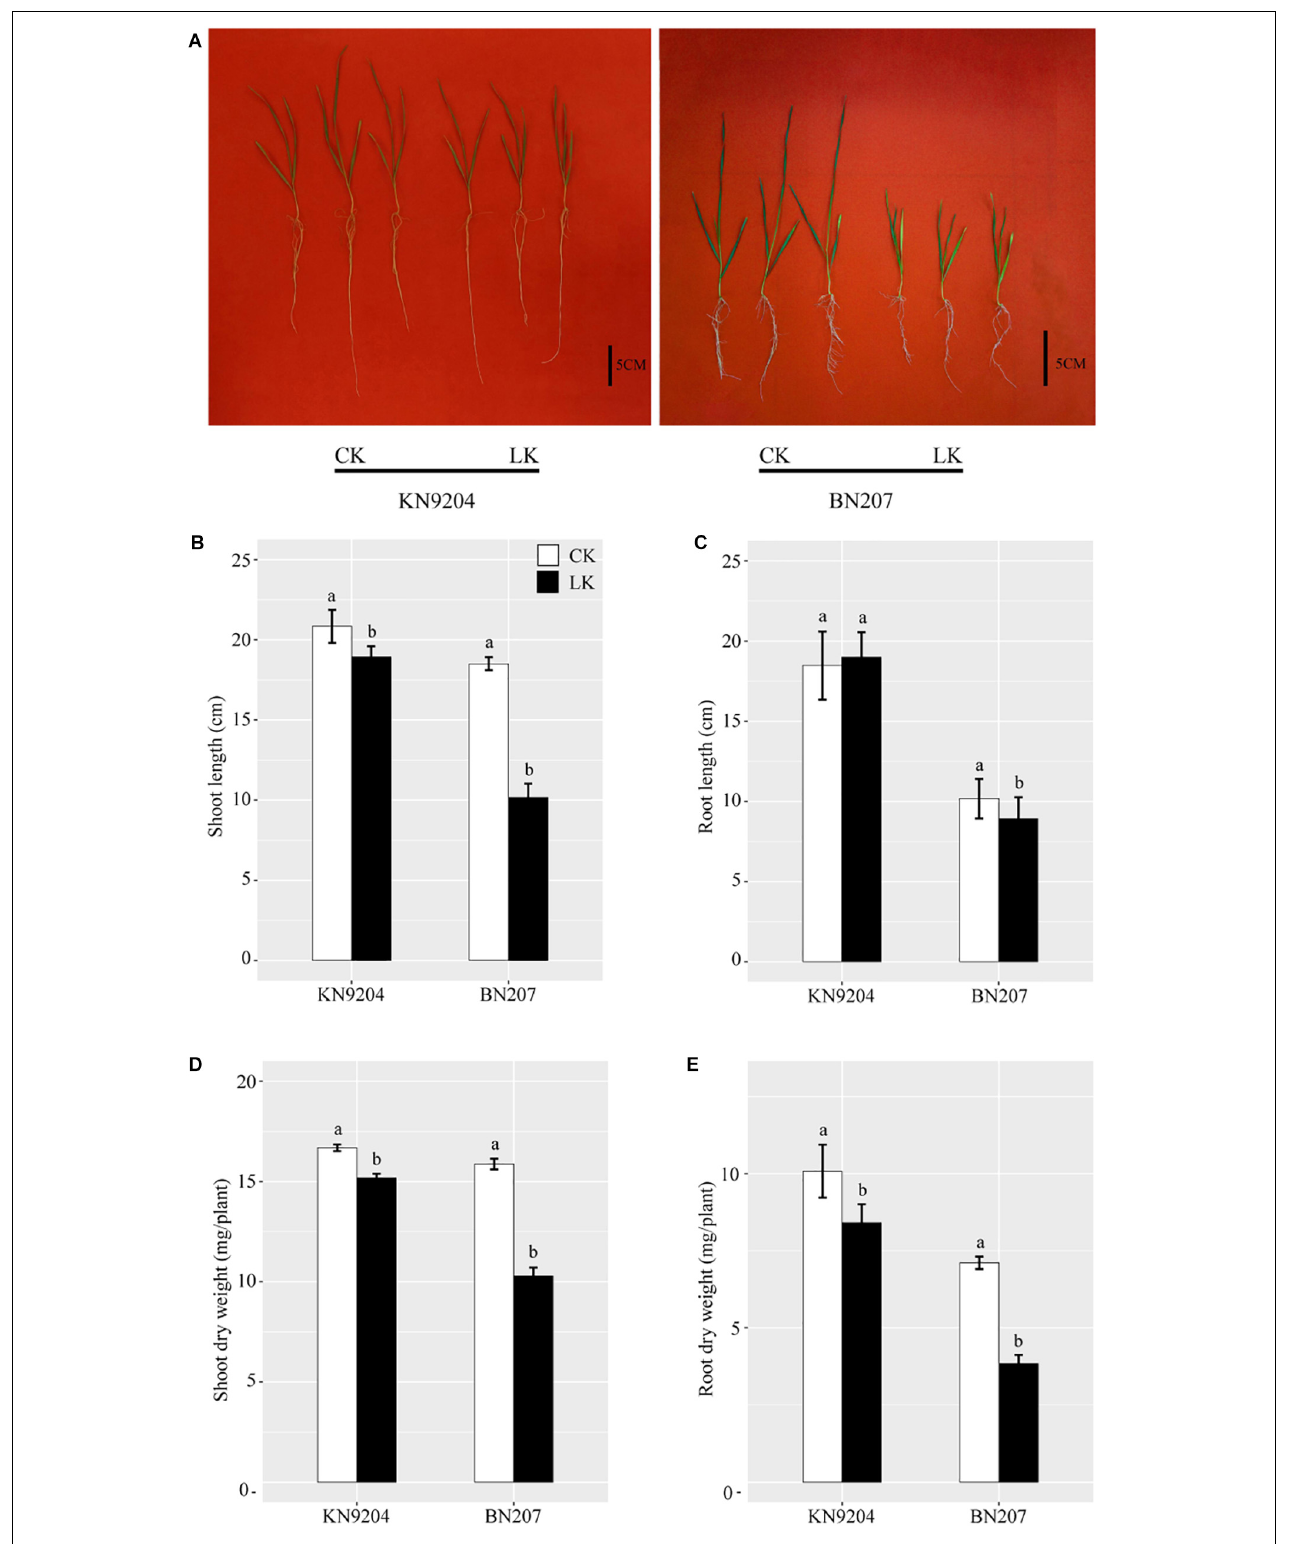
FIGURE 1 | Growth performance of KN9204 and BN207 after 14 days under control (CK) and low-K (LK) stress conditions. (A) KN9204 plants (left) and BN207 plants (right). Bar, 5 cm. (B) shoot length, (C) root length, (D) shoot dry weight, and (E) root dry weight of KN9204 and BN207 plants. Data are presented as the mean ± SD of three biological replicates ( n = 3). Lowercase letters indicate significant differences ( p < 0.05) as determined by a one-way ANOVA.